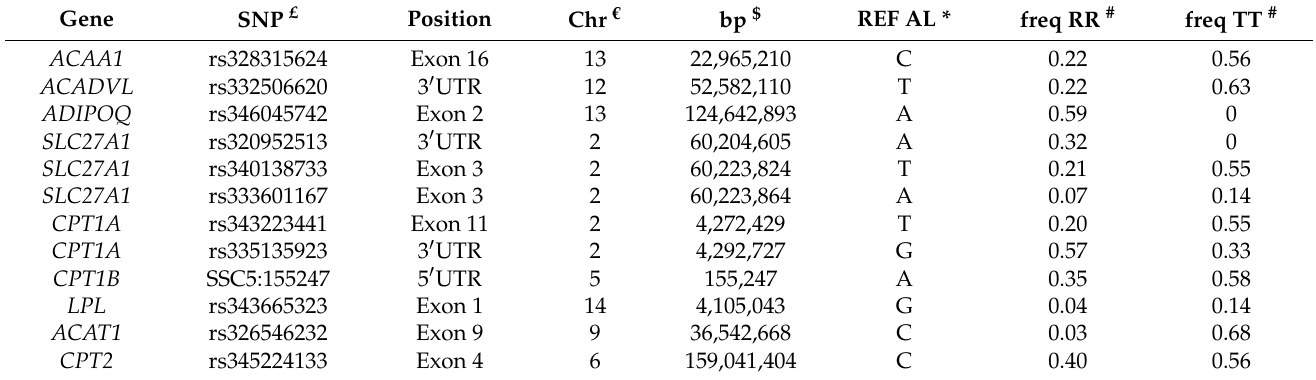
Table A3. Associated gene, identifier, location, reference allele, frequencies in Retinto (RR) and Torbiscal (TT) pigs of the 12 SNPs selected for